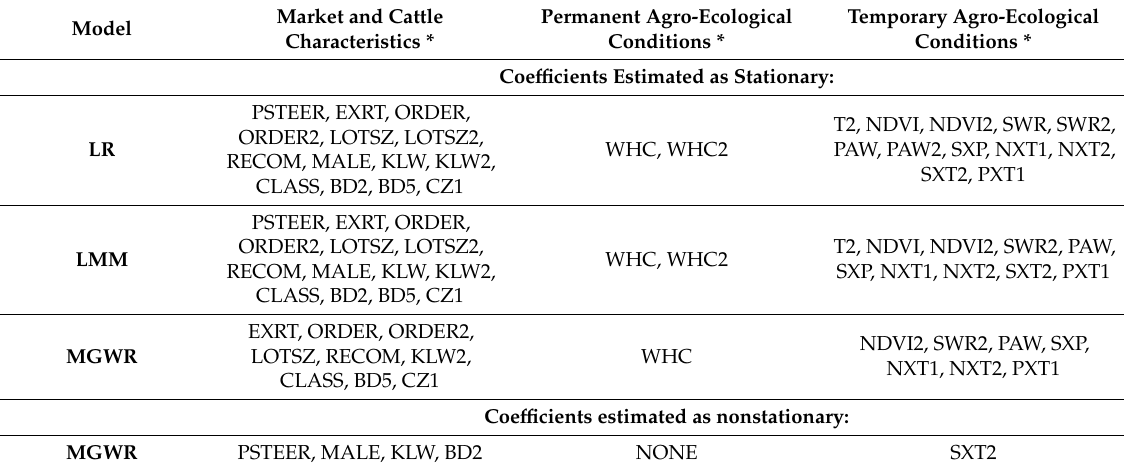
Figure 4. Mean and standard deviation residual maps from the three study models (LR, LMM, and MGWR). Each mean map is given with the same legend breaks from the LR fit only. Table 4. Summary of study results: significant coe ffi cients